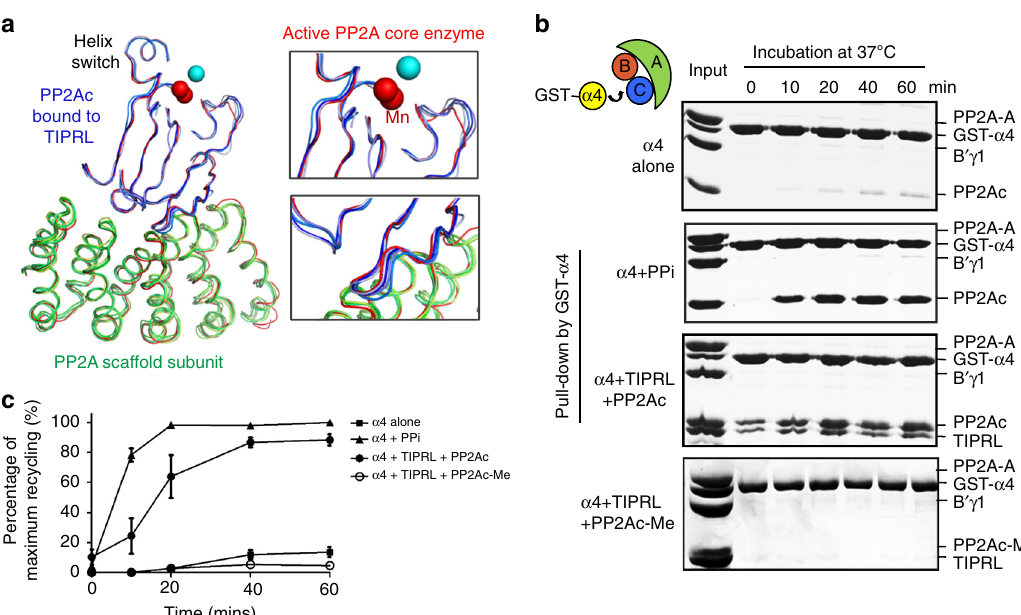
Fig. 6 TIPRL-mediated structural attacks on PP2Ac and α 4/TIPRL-mediated PP2A holoenzyme disassembly. a Overlaid structures of the active PP2A core enzyme (red) and the four asymmetric copies of the TIPRL-bound core enzyme (colored as in Fig. 1), with close-up views on the active site (upper right) and the A-PP2Ac interface (lower right). Manganese ions bound to active and TIPRL-bound PP2Ac are in red and blue spheres, respectively. b Co- incubation of unmethylated or methylated PP2A-B ’ γ 1 holoenzyme with GST- α 4 in the presence or absence of PPi or TIPRL at 37 °C, followed by pulldown via GS4B after the indicated incubation times. The bound proteins were examined on SDS-PAGE. c Time-dependent recycling of PP2Ac with the α 4-bound PP2Ac at different time points were normalized to GST- α 4 and then quanti fi ed as percentage of that at 60 min of “ α 4 + PPi ” -mediated recycling. The quanti fi ed mean ± s.e.m. were then